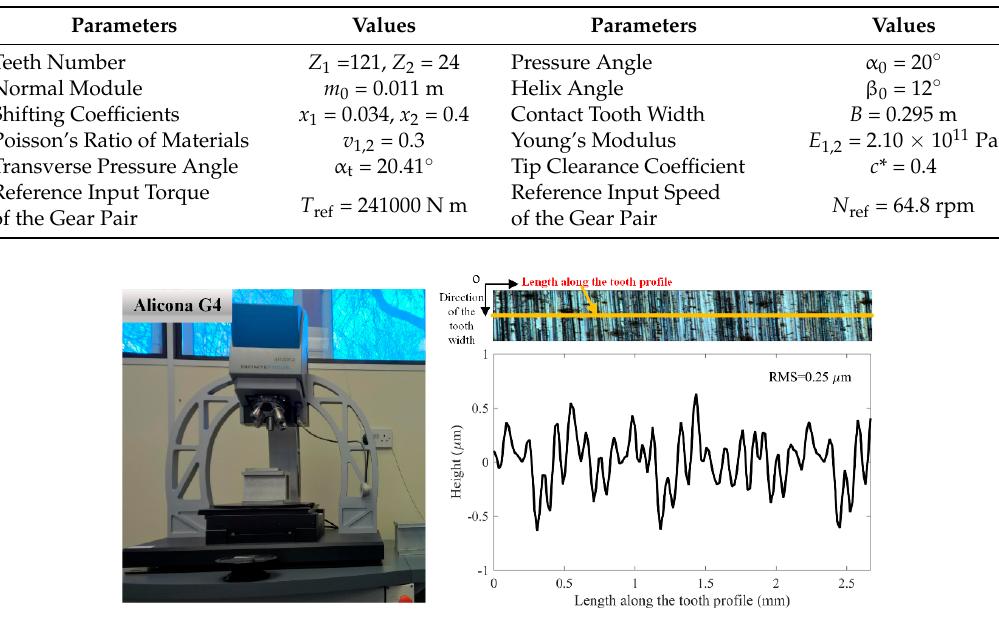
Figure 7. The optical profiler and the initial surface roughness profile.